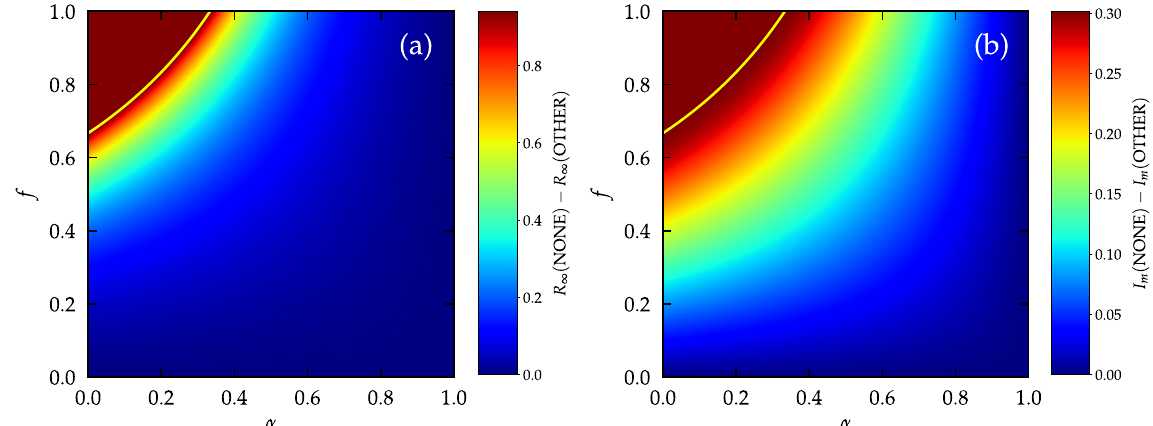
Figure 2. OTHER interventions flatten the curve but barely reduce prevalence with respect to no intervention. ( a ) Difference between the final prevalence R for the NONE and the OTHER scenario as a function of the fraction f of adopters and the efficacy α of the individual PI. ( b ) Difference between the maximum value of the incidence I m for the NONE and the OTHER scenario as a function of the fraction f of adopters and the efficacy α of the individual PI. Solution of MF equations for a homogeneous network of degree K = 7 for (cid:31) = 0.5 . The solid yellow lines are where (cid:31) c (α) = (cid:31) for the OTHER scenario.